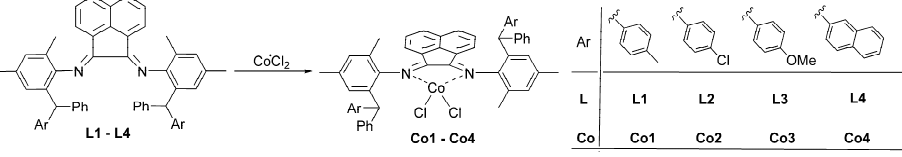
Scheme 1. Synthetic procedure for cobalt complexes Co1–Co4 .